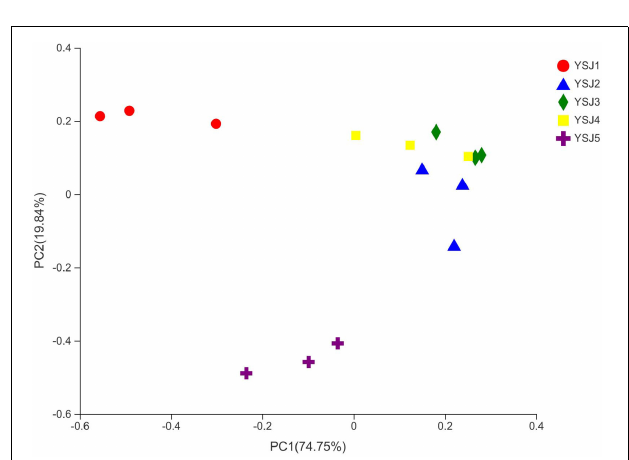
FIGURE 6 | Multiple sample principal coordinate analysis (PCoA) of the OTU level. Both selected principal component axes are represented by the x-axis and y-axis , and percentage represents the difference in sample composition by principal component; scales of x-axis and y-axis represent relative distances. Samples are represented by different color points or shapes in different groups. Closeness of points or shapes represents similarity level between fungal species